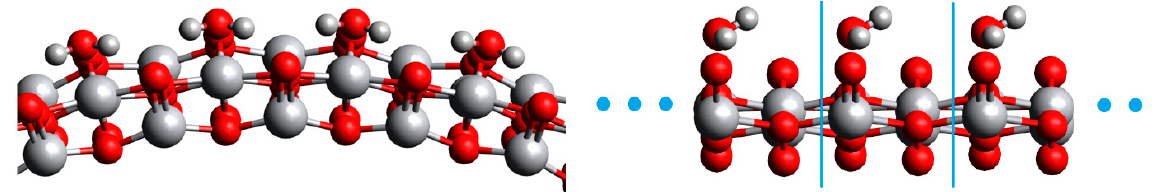
Figure 4. Fragment of a 6-layered (101) TiO 2 NT (40,0) and its 2D FVS model, with a multiplied unit cell.